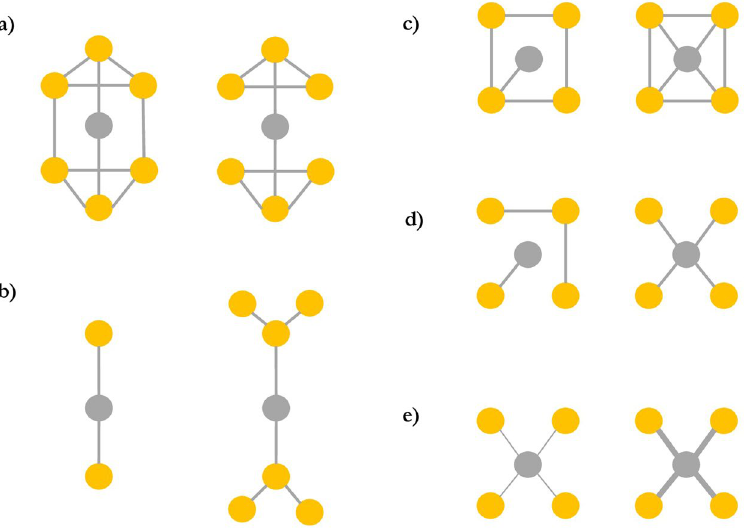
Figure 1. Visualisation of five measures of network centrality for ( a ) betweenness, ( b ) eigenvector centrality, ( c ) closeness, ( d ) degree and ( e ) strength. In each image the focal node is shaded grey and all other nodes yellow. The thickness of the tie represents the ‘strength’ of the relationship. In each measure of centrality, the image on the left represents low centrality, the right high. For instance, in (d) the figure to the left reveals that the focal ego is only tied to one other individual, while in contrast in the right figure the focal ego is connected to four nodes, thus representative of higher degree. Figures (d,e) are direct measures of centrality, the others are indirect. Adapted from ref.